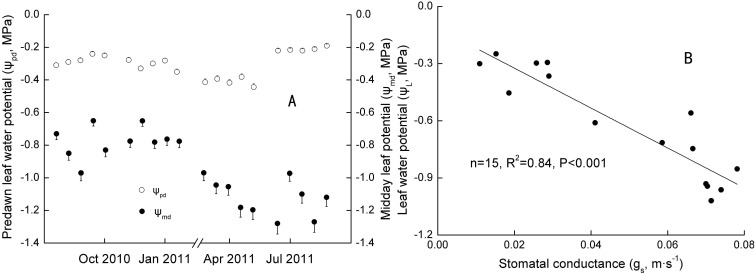
Seasonal changes and Linear regression of predawn and midday water potential.R2 was the coefficient of determination; p was significance. p < 0.1, p < 0.05, and p < 0.01 standed for a significant, remarkable and very significant difference, respectively.